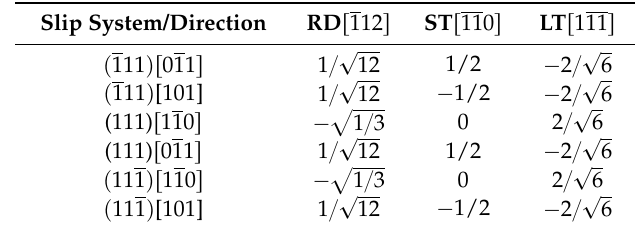
Table 3. Shear stress distribution of slip systems in the three directions of the Brass orientation {110}<112> when the tensile direction is along the long-transverse direction.